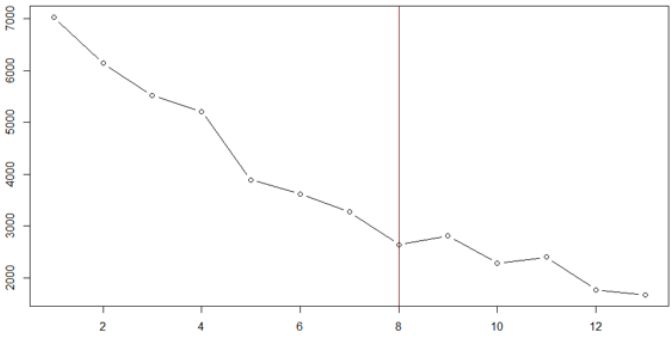
Figure 4. A screenplot of the number of clusters. Source: own processing (R Studio). The line dividing the axis determining the eight clusters represents the optimum state—in this case, the inside of the cluster has the optimum value of the squares. The process was continued by selecting the number of enterprise clusters. According to the heuristic approach, eight clusters were made using a screenplot. The number of clusters is illustrated by the x -axis, and the intra-cluster square is illustrated by the y -axis. The decision was made by minimizing the intra-cluster sum of the square. The number of enterprises in each cluster is shown in Table 3. Table 3. Clusters of municipalities. Cluster